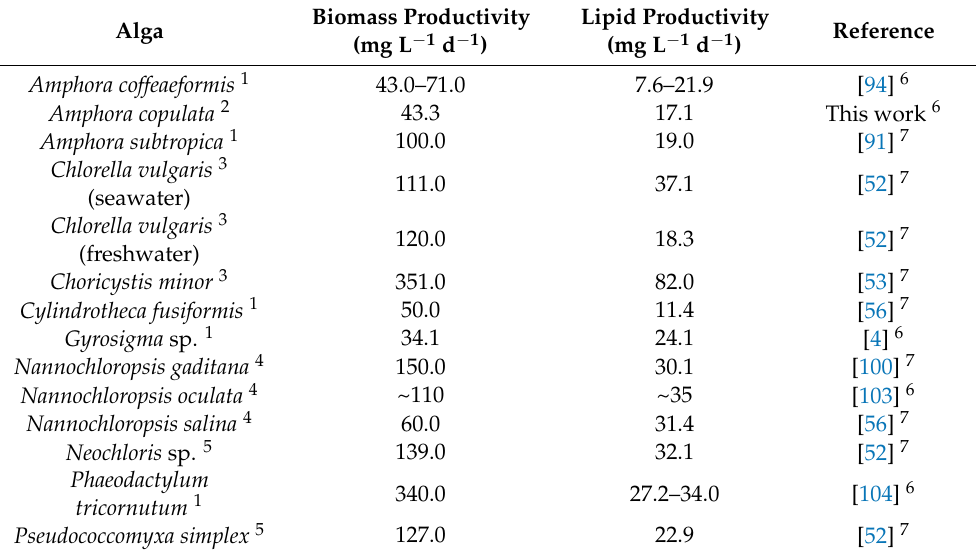
Table 3. Biomass and lipid productivities of some